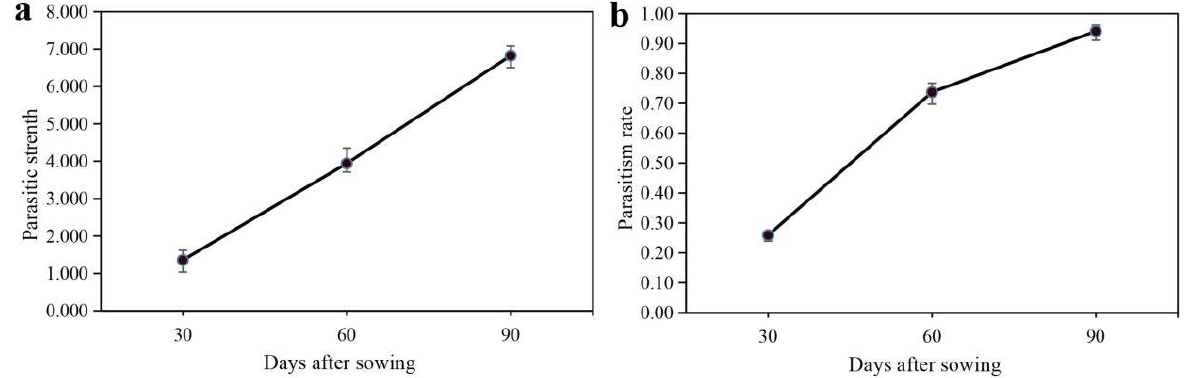
Figure 1. O. cumana identification in field of SQ25. ( a ) Parasitic strength of SQ25 after sowing; ( b ) parasitic rate of SQ25 after sowing.